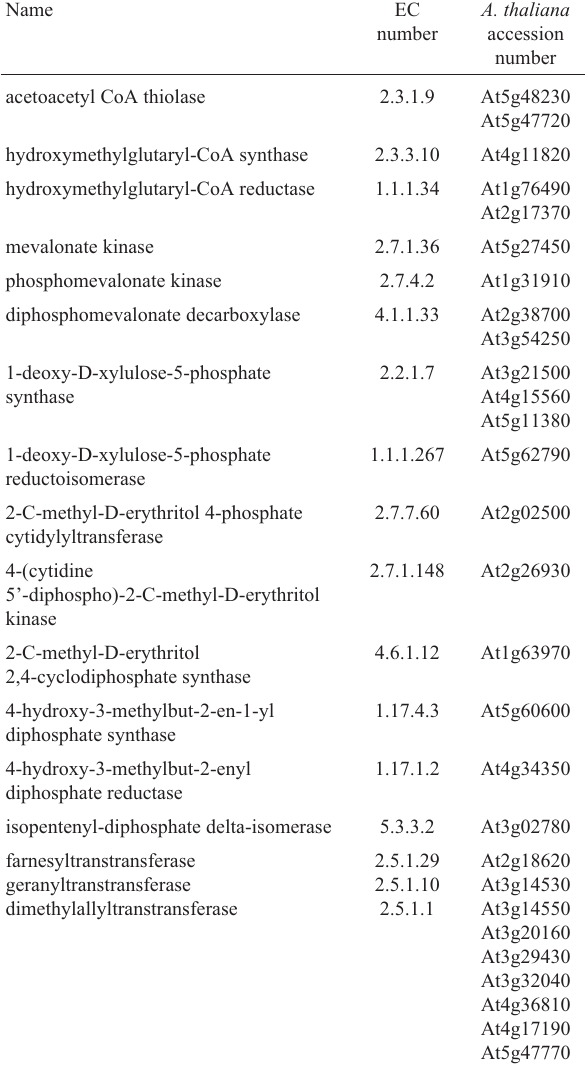
Table 1 - Enzymes of Arabidosis thaliana used for the search of the CitEST database. The enzymes listed in the first column were searched in the CitEST database using the genes of Arabidopsis thaliana , listed in the last column. In column 2 are listed the EC numbers for each enzyme obtained from